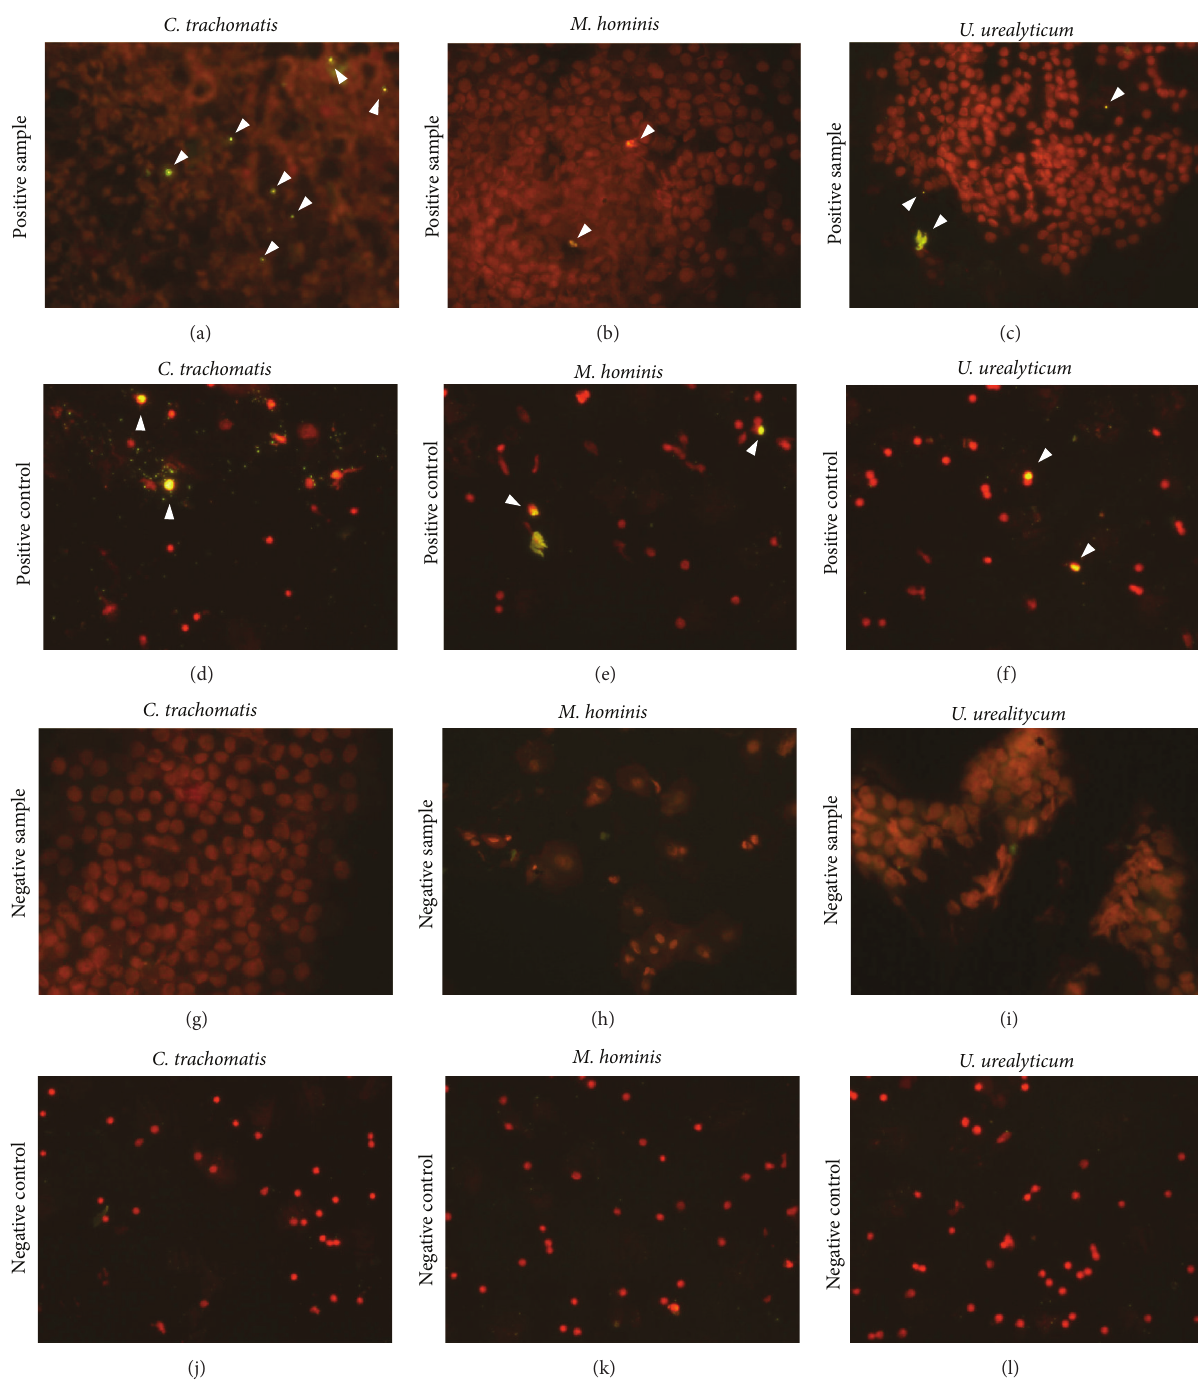
Figure1:Directfluorescenceassay(DFA)stainingforthedetectionof C.trachomatis , M.hominis, and U.urealyticum infectioninconjunctival scrape smears of a dry eye patient ((a)–(c)), positive control slides ((d)–(f)), conjunctival scrape smears of a nondry eye patient ((g)–(i)), and negativecontrolslides((j)–(l)).NotethespecificDFAstainingpatterns(small,welldefined,round,apple-greenorlarge,moderatebrightgreen loci of fluorescence) in panels (a)–(f) (arrowheads) and absence of specific fluorescence in panels (g)–(l). DFA with Evans blue counterstain, original magnification ×